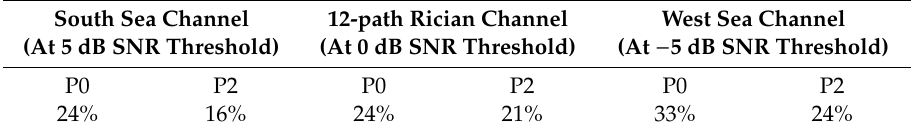
Figure 11. Outage performance comparison for PA case 0: P0 versus PA case 1: P2. Table 6. Outage comparison at 50%